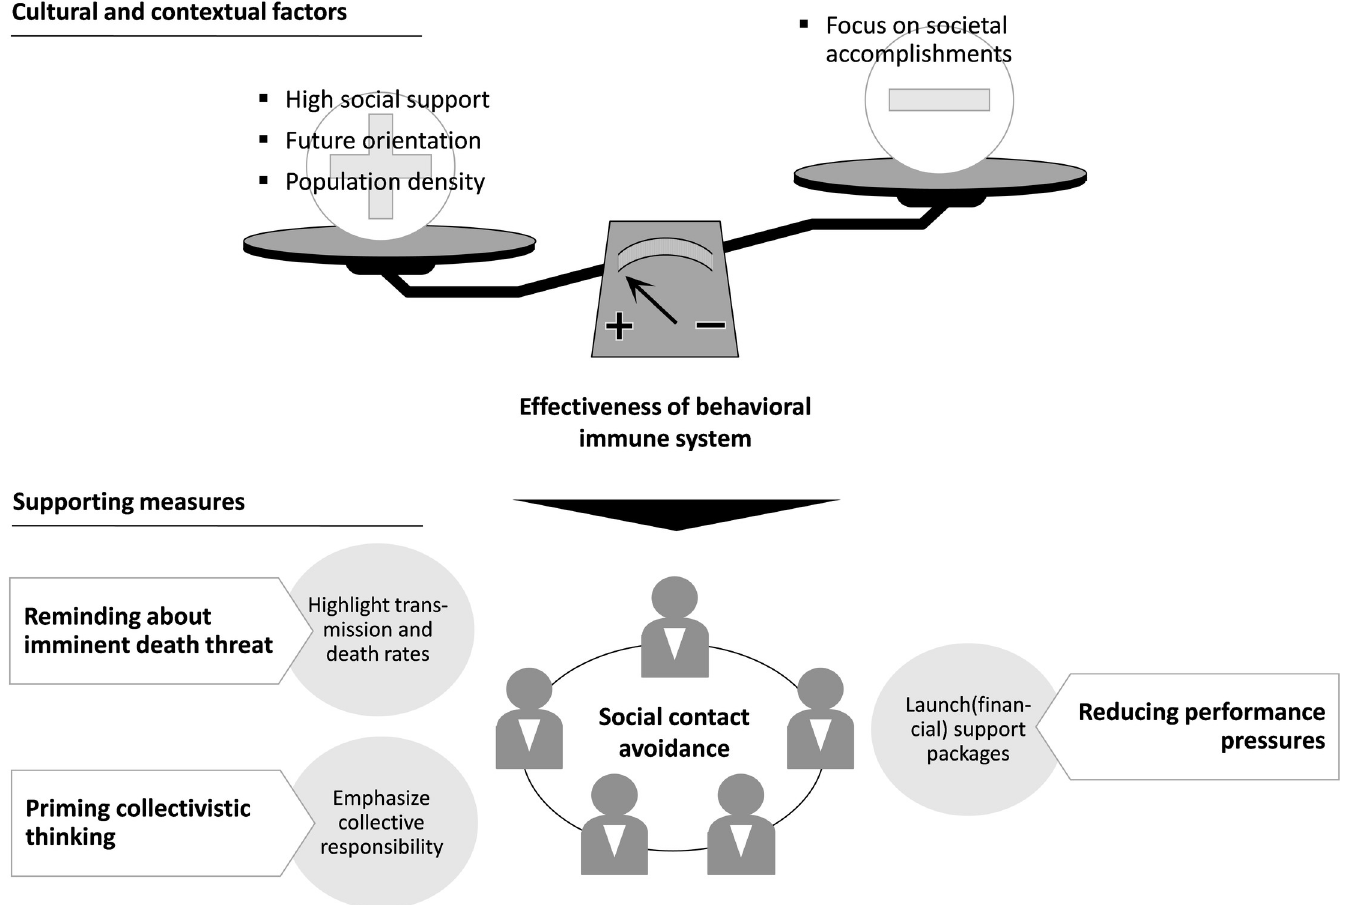
Fig 4. Policy and practical implications. This chart summarizes the study’s policy and practical implications. Because defensive behavior in a pandemic only makes sense at the group level, health-based communication needs to consider cultural and other contextual